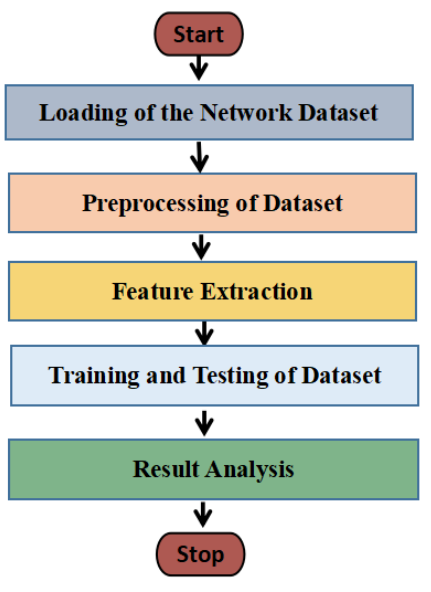
Figure 8. Flowchart of Intrusion Detection Scheme.